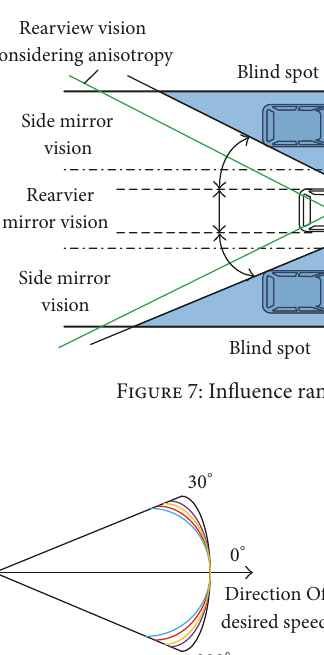
Figure 6: Schematic diagram of vehicle modeling.